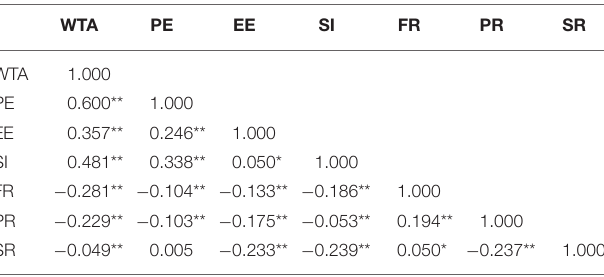
TABLE 3 | Correlation coefficient among core variables ( N = 1,655).